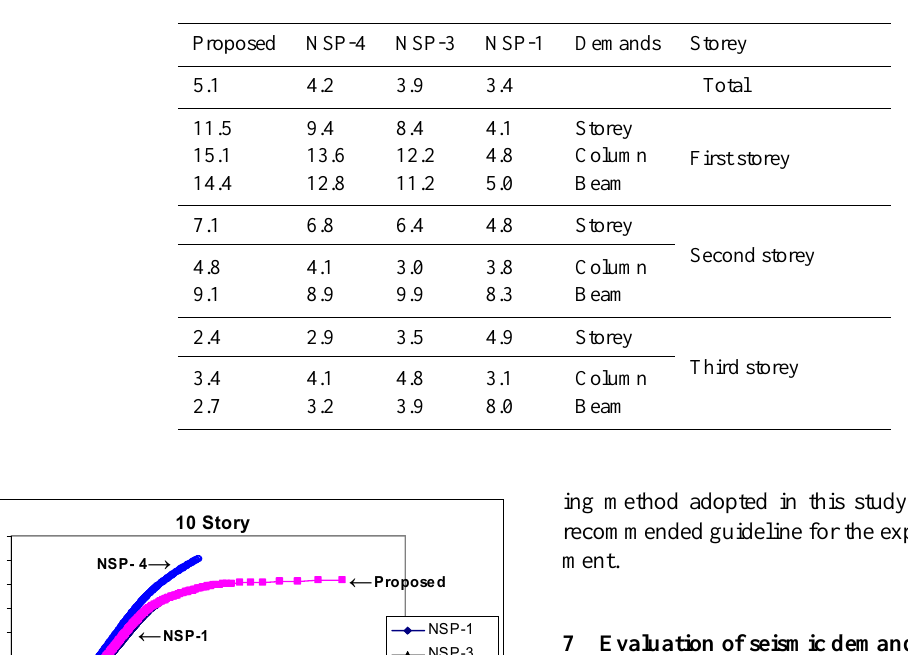
Table 6. Summary of ductility demands for 3-storey building.